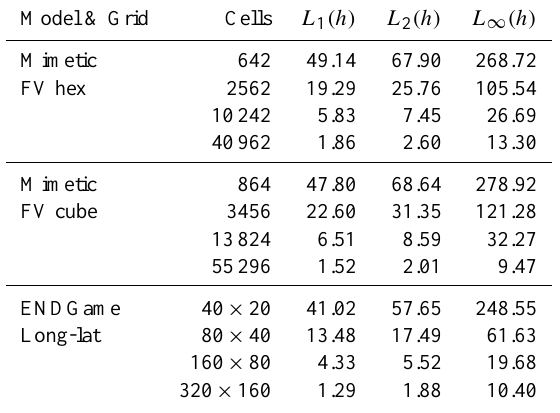
Table 7. Height errors (m) for test case 5, with reduced time steps. Model & Grid